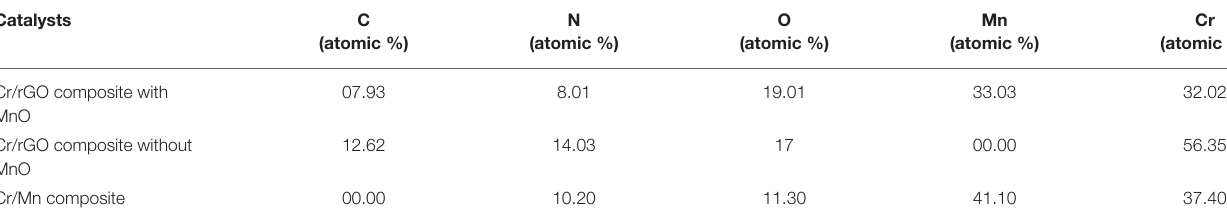
TABLE 1 | The atomic percentage of each element obtained from ICP-OES of Cr/rGO composite with MnO. Catalysts C (atomic %)